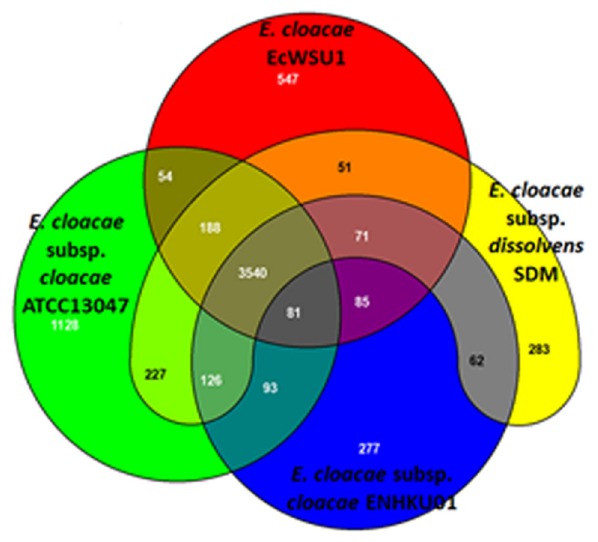
Figure 4. Venn diagram of four E. cloacae strains. The Venn diagram shows the pan-genome of ATCC13047, SDM, EcWSU1 and ENHKU01 generated using EDGAR [27]. Overlapped regions represent common CDS shared between the E. cloacae genomes. The number outside the overlapped regions indicates the number of CDS in each genome without homologs in other sequenced E. cloacae